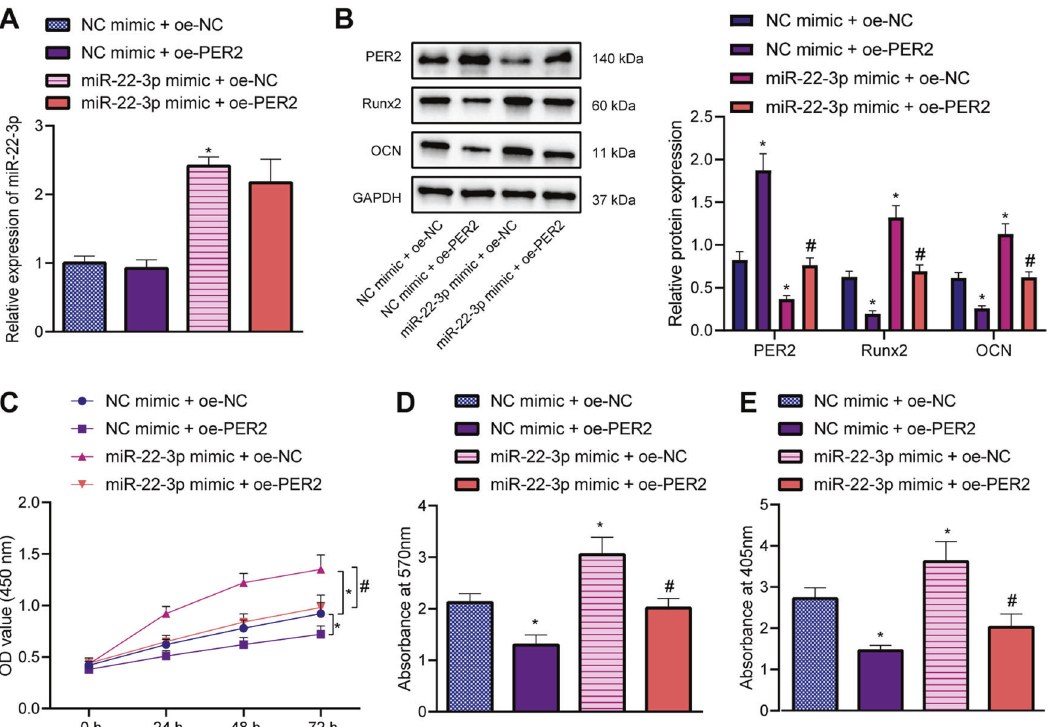
Fig. 4 miR-22-3p repressed PER2 to induce the osteogenic differentiation of AS-BMSCs. A miR-22-3p expression in AS-BMSCs treated with miR-22-3p mimic, oe-PER2, or in combination determined by RT-qPCR. B The protein expression of PER2, Runx2 and OCN in AS-BMSCs treated with miR-22-3p mimic, oe-PER2, or in combination determined by Western blot analysis. C The viability of AS-BMSCs treated with miR-22-3p mimic, oe-PER2, or in combination detected by CCK-8 assay. D Mineralization of AS-BMSCs treated with miR-22-3p mimic, oe-PER2, or in combination detected using Alizarin red staining. E ALP content of AS-BMSCs treated with miR-22-3p mimic, oe-PER2, or in combination detected by ALP staining. * p < 0.05 vs. AS-BMSCs treated with NC mimic + oe-NC, # p < 0.05 vs. AS-BMSCs treated with miR-22-3p mimic + oe- NC. The cell experiment was repeated three times independently.